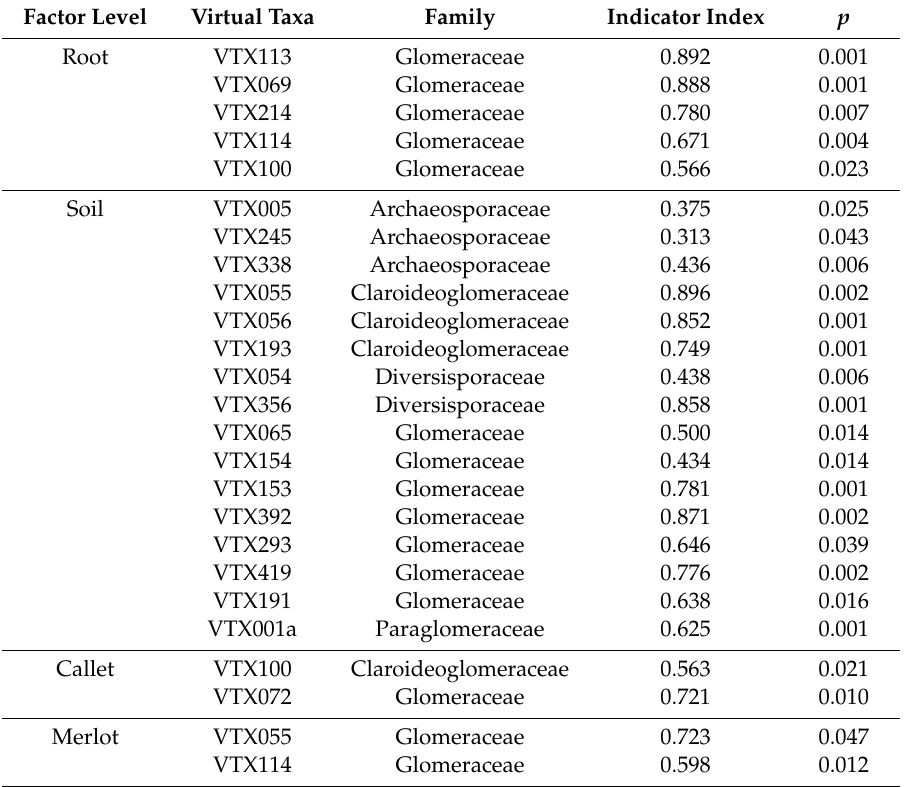
Table A3. Indicator AM fungal VT tied to di ff erent levels of sample type: Soil vs. root; and vine cultivar: Callet vs.